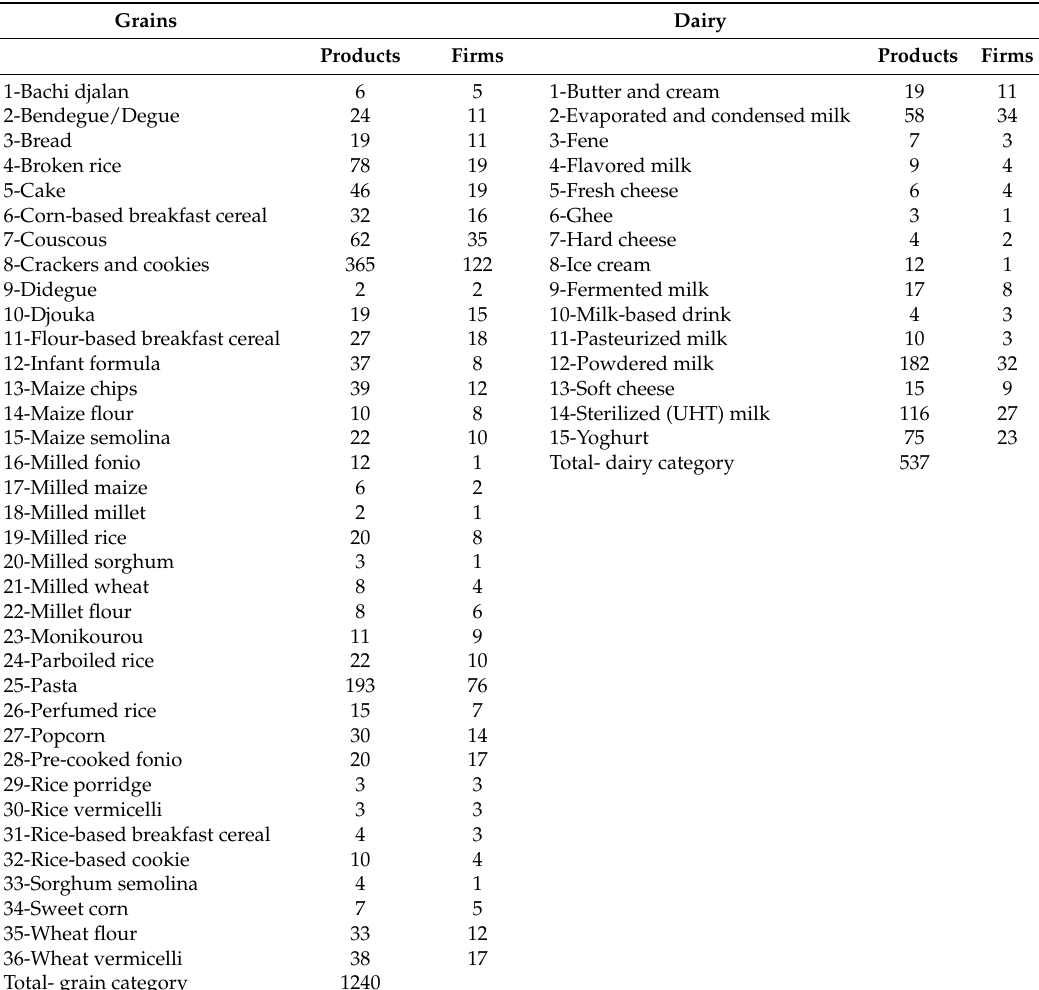
Table 1. Diversity of grain and dairy products and number of associated manufacturing firms (Source: Inventory dataset (2016), as computed by the authors). Grains